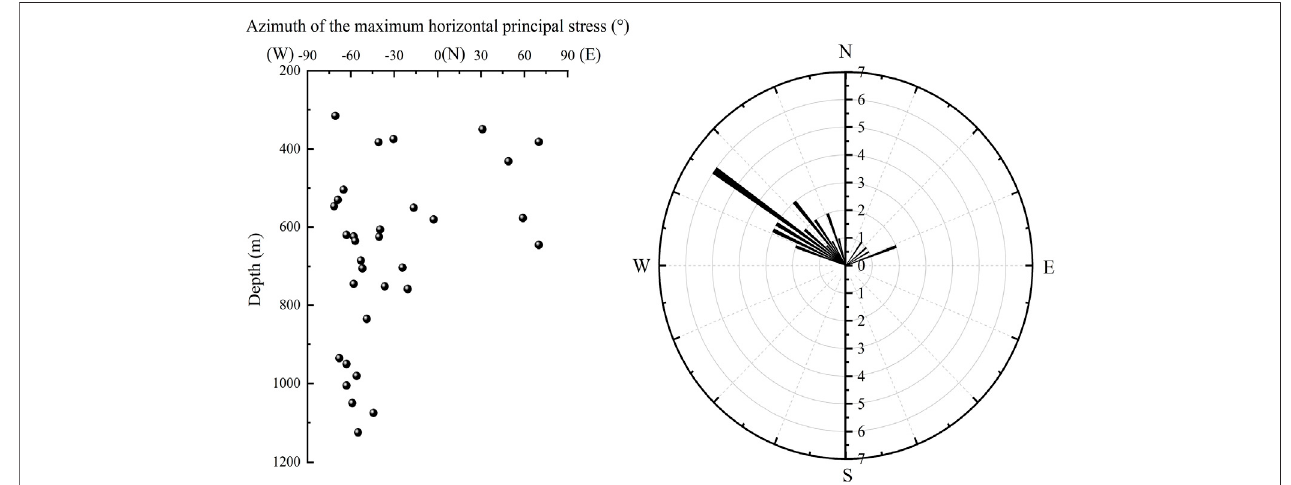
FIGURE 6 | Direction of the maximum horizontal principal stress.